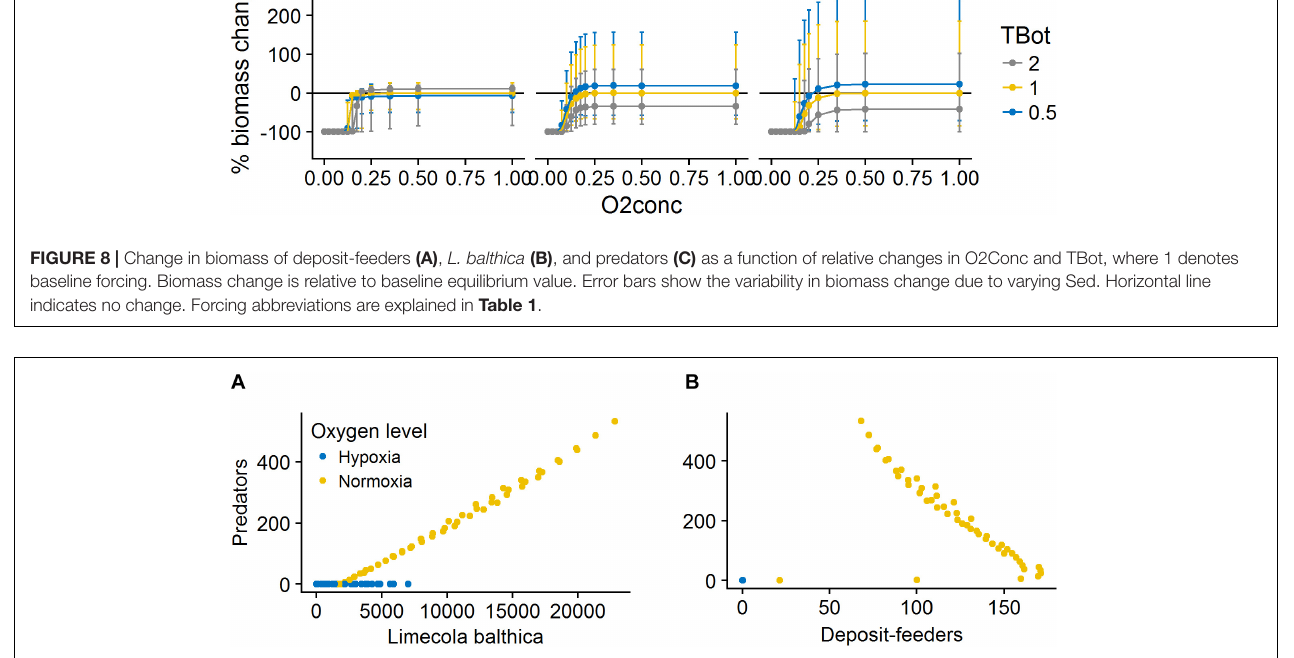
FIGURE 9 | Relationship between biomass of L. balthica and predators (A) and surface deposit-feeders and predators (B) at hypoxia (O2Conc < 0.1, blue) and normoxia (baseline O2Conc, yellow). Biomass values are in mg C m − 2 . Forcing abbreviations are explained in Table 1